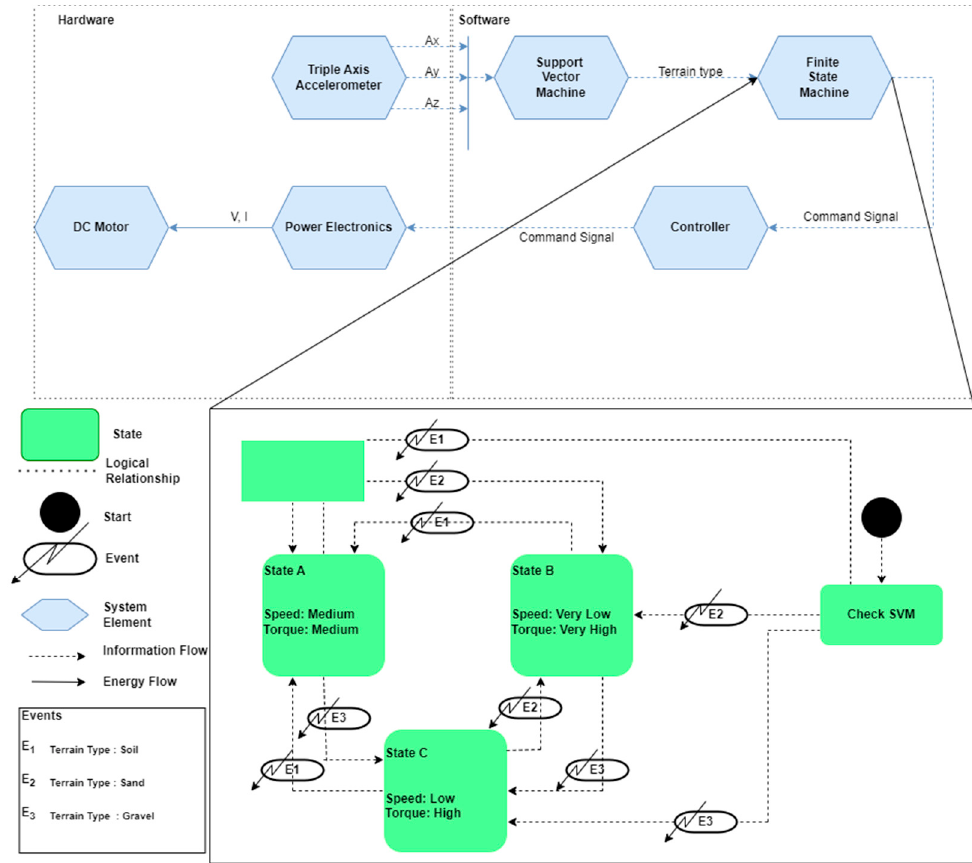
Figure 1. Proposed Robot Mechanism by Mahadhir et al. [8].